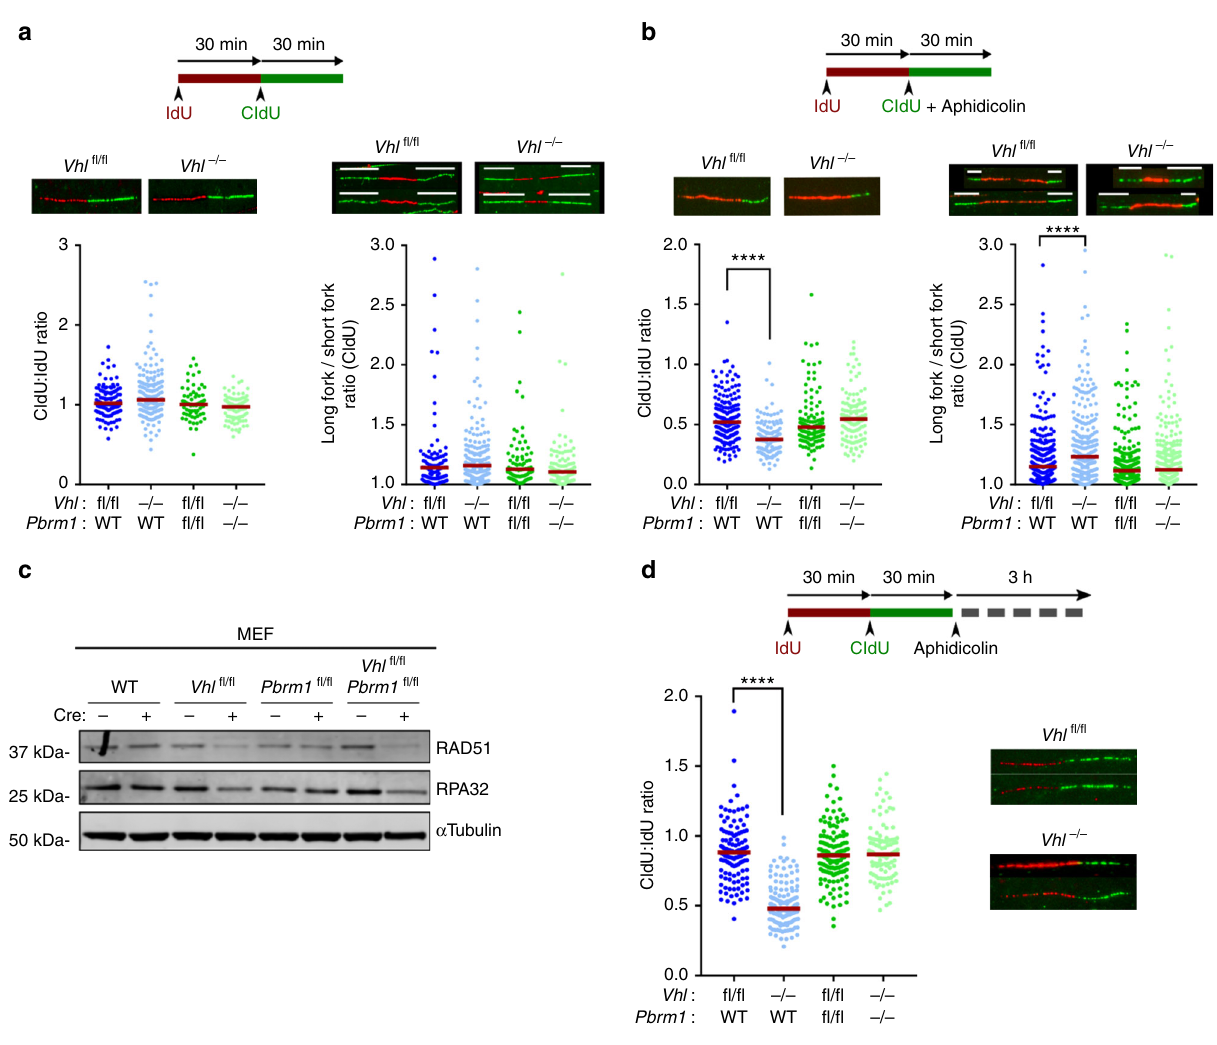
Fig. 2 Loss of VHL induces replication fork stalling and collapse. a , b DNA fi bre analyses following the indicated treatments. Top: DNA fi bre assay experimental design. Bottom left: Representative images of labelled replication tracts and dot plot of CIdU:IdU track ratio in MEFs of indicated genotype (data from representative experiment; n > 85 tracts analysed for each genotype per experiment, n (independent experiments) = 3). Bottom right: Representative images of replication forks (white tracts indicate the lengths of the bidirectional forks analysed) and quanti fi cation of replication fork asymmetry ( n > 50 forks in total per genotype, data pooled from n (independent experiments) = 3). c Representative immunoblots of MEFs. d Top: Experimental design of fork protection assay. Bottom left: Dot plot of of CIdU:IdU track ratio in MEFs (data from representative experiment, n > 220 tracts analysed for each genotype per experiment, n (independent experiments) = 3). Bottom right: Representative images of labelled replication tracts. a , b , d Median values shown in red; Kruskall – Wallis, Dunnet ’ s correction **** p <